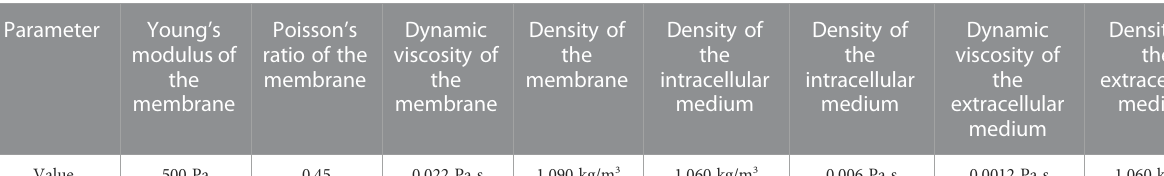
TABLE 1 Shear fl ow fi eld setting parameters.